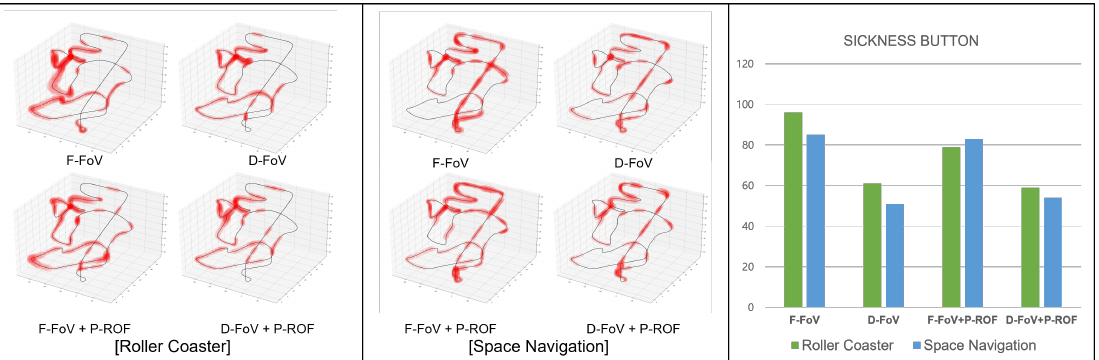
Figure 6. Visualization of the total occurrences of “severe sickness” button pressed during the navigation—roller coaster ride (far left) and space navigation (middle)—among the four test condi- tions. D-FoV, F-FoV+P-ROF, and D-Fov+P-ROF all showed fewer button presses than the baseline F-FoV, but a clear winner was not identified.